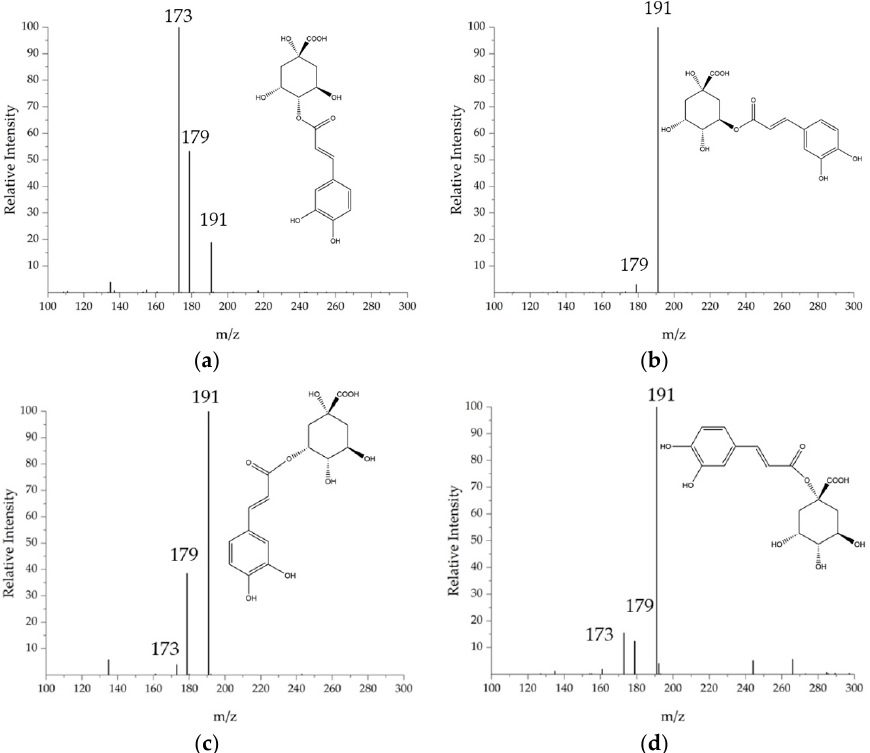
Figure 5. Tandem mass spectra of the compounds 1 , 2 , 3 , and 4 , identified as chlorogenic acids: ( a ) 4-CGA, ( b ) 5-CGA, ( c ) 3-CGA, ( d ) 1-CGA.